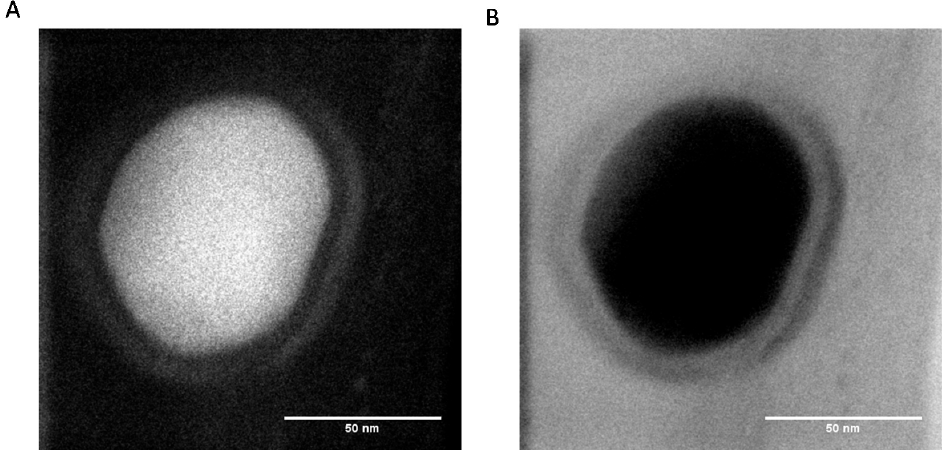
Figure 3. High-resolution STEM images acquired simultaneously in ( A ) high-angle annular dark field and ( B ) bright field modes of PDA@ALP nanoparticles obtained after 6 h of oxidation of a 10 mM dopamine solution + 1 mg ∙ mL − 1 ALP in the presence of 20 mM NaIO 4 .